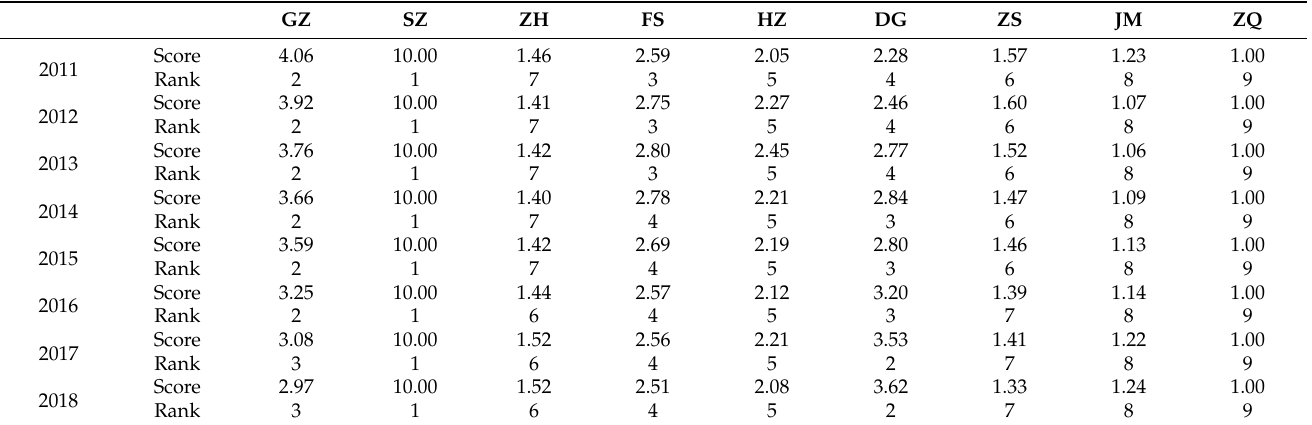
Table 5. Evaluation scores of the technological